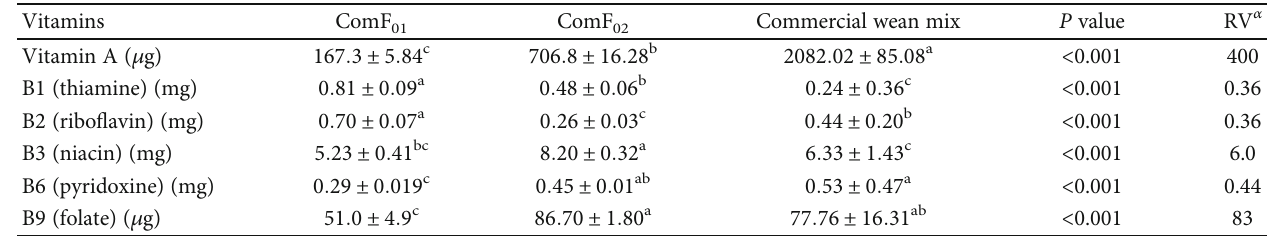
Table 3: Vitamin composition of complementary foods and commercial wean mix per